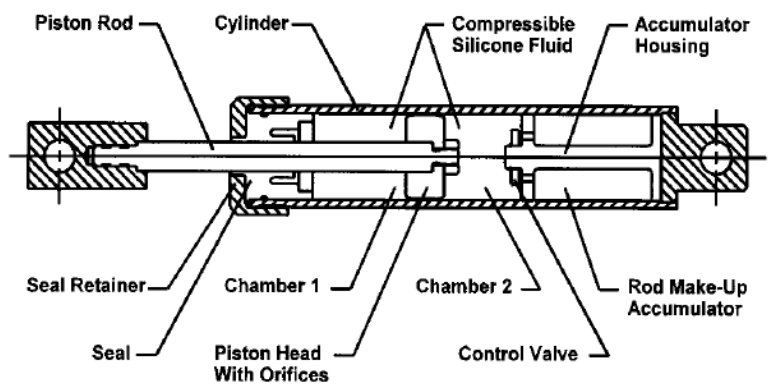
Figure 4. Typical components of viscous damper reproduced from [41].